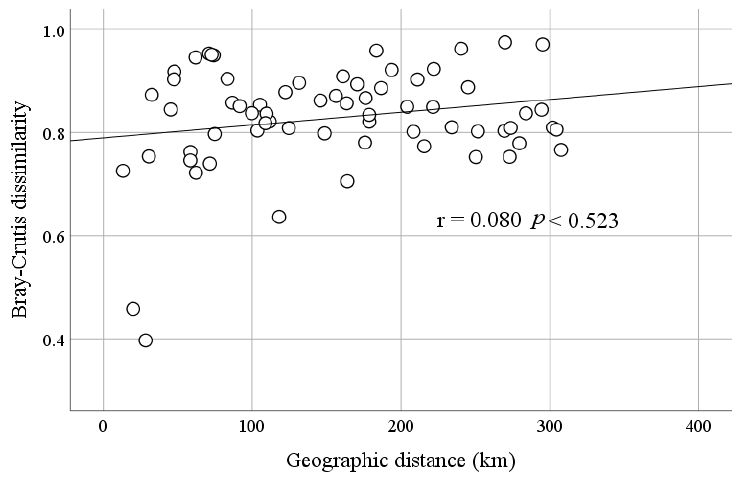
Figure 9. Spearman correlation between Bray–Curtis dissimilarities of microbial communities and geographic distance among the sampled lakes on the Tibetan Plateau, China.